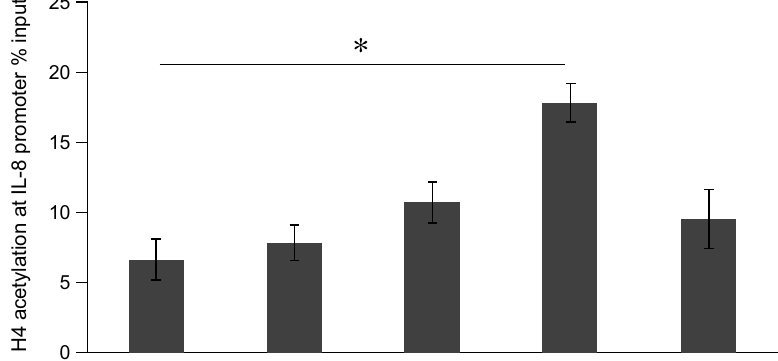
Figure 3. Time course analysis of lipopolysaccharide (LPS)-induced histone H4 acetylation at the promoter region of the interleukin-8 (IL-8) gene in A549 cells in vitro . A549 cells were stimulated 0 ~ 3 hr with LPS (10μg/ml). The results presented are from ChIP analyses using anti-acetyl H4 antibodies. All PCR signals from immunoprecipitated DNA were normalized to PCR signals from non-immunoprecipitated input DNA. Results are expressed as percentage of the input. Data were expressed in mean±SEM. *P<0.05: compared to LPS 0hr stimulated cells (Mann-Whitney U test), n=4.